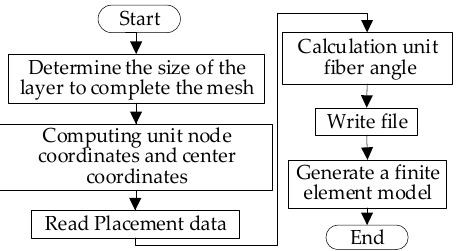
Figure 3. Process of creating an analytical model for variable-angle laminates.